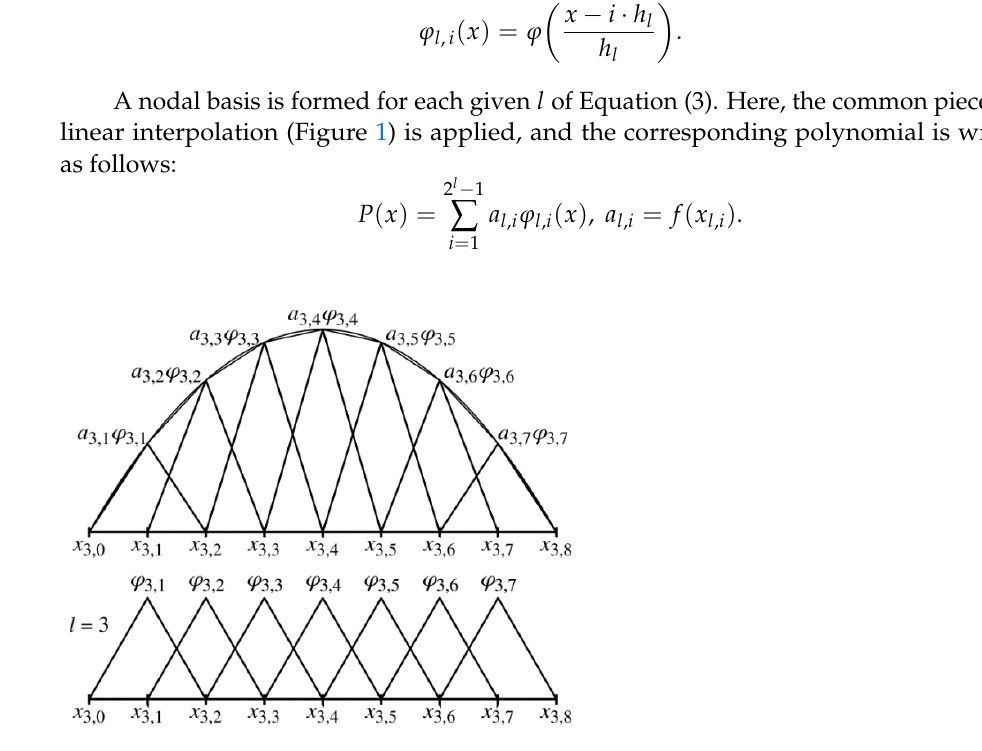
Figure 1. Interpolation on a nodal basis.